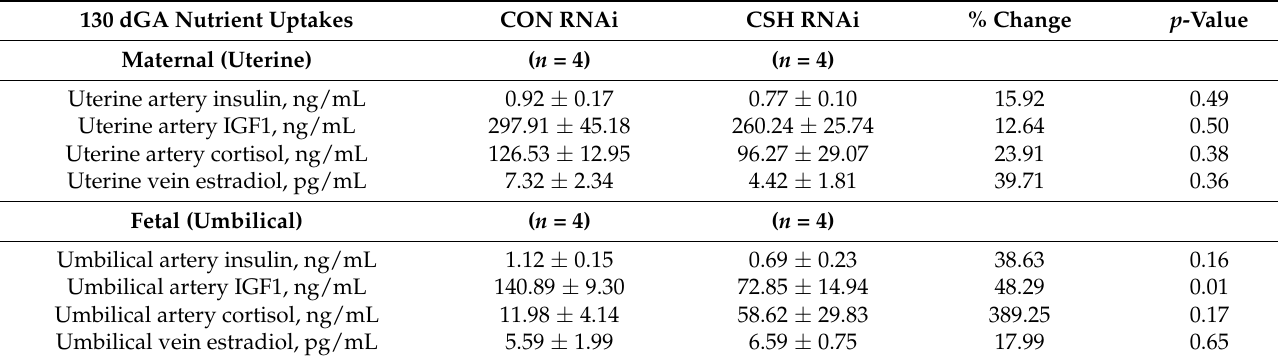
Table 5. Concentrations of maternal or fetal